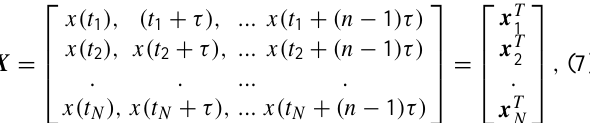
Fig. 4. (a, b) The spectra of the singular values σ i ,i = 1 − 15 corresponding to the purely deterministic x(t) Lorenz signal, to the stochastic x(t) Lorenz signal and its V 1 , V 2 − 15 SVD components estimated for the levels e = 0 . 1 (37%) and e = 0 . 5 (39%) of the external noise